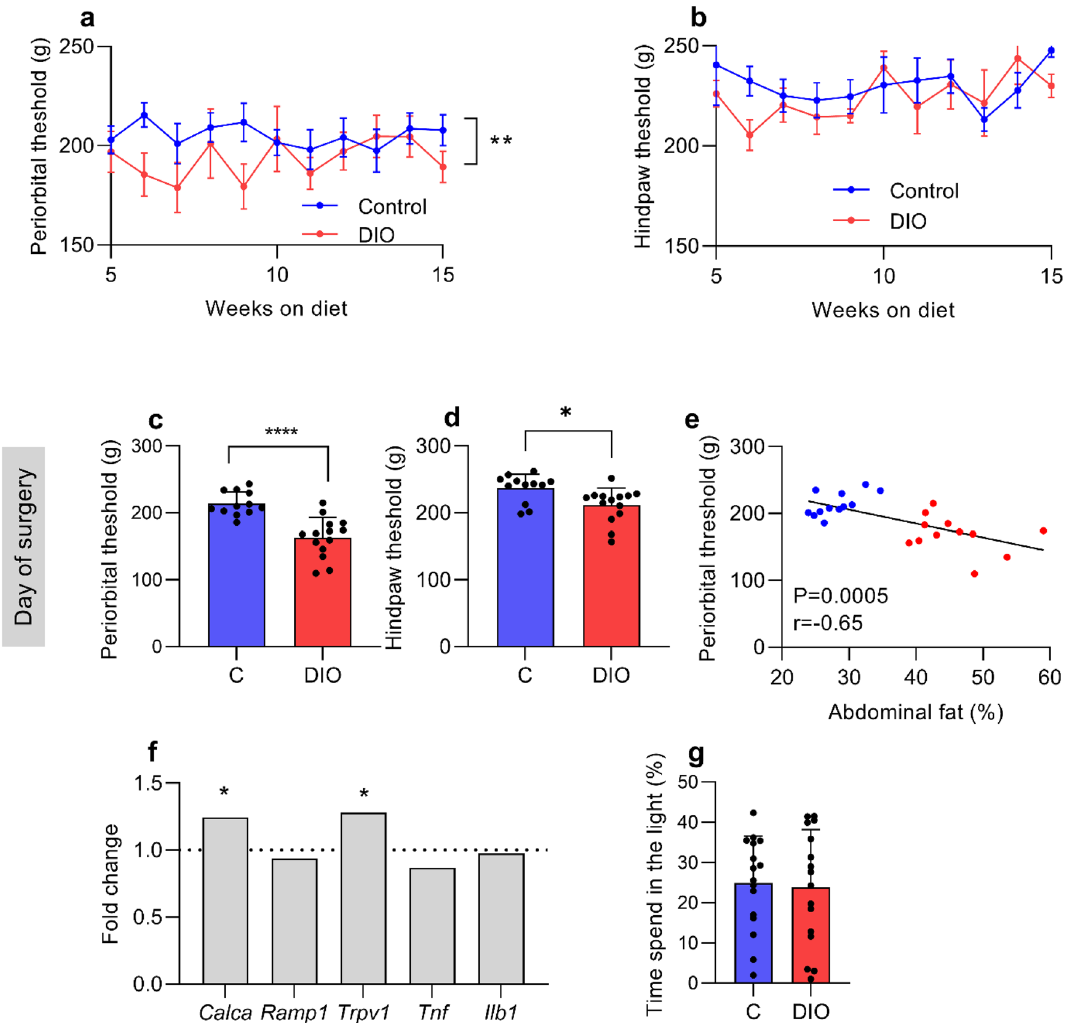
Figure 3. DIO induces cephalic allodynia. Peripheral and cephalic pain thresholds in female Sprague–Dawley rats on control and DIO rats. Longitudinal periorbital ( a ) and hindpaw ( b ) Von frey thresholds during weight gain. Periorbital ( c ) and hindpaw ( d ) Von frey testing on day 0. ( e ) Scatter graph of abdominal fat vs periorbital threshold on day 0, blue dots represent controls, red dots represent HFD rats. ( f ) Fold change in expression of Calca , Ramp1 , Trpv1 , Tnf and Ilb1 in trigeminal ganglia of DIO rats, dotted line represents controls. ( g ) Photophobia testing of rats two weeks prior to surgery (N = 16 control and DIO). Two-way repeated measure ANOVA for ( a,b ). Unpaired students T-test for ( c,d ). Pearson’s correlation for ( e ). *P < 0.05, **P < 0.01 and ****P < 0.0001. Control N = 12 and DIO = 14. N = 9 for TG RT-qPCR. Data presented as mean ± SEM for ( a,b ), mean + SD for ( c,d,g ), geometric mean for ( f